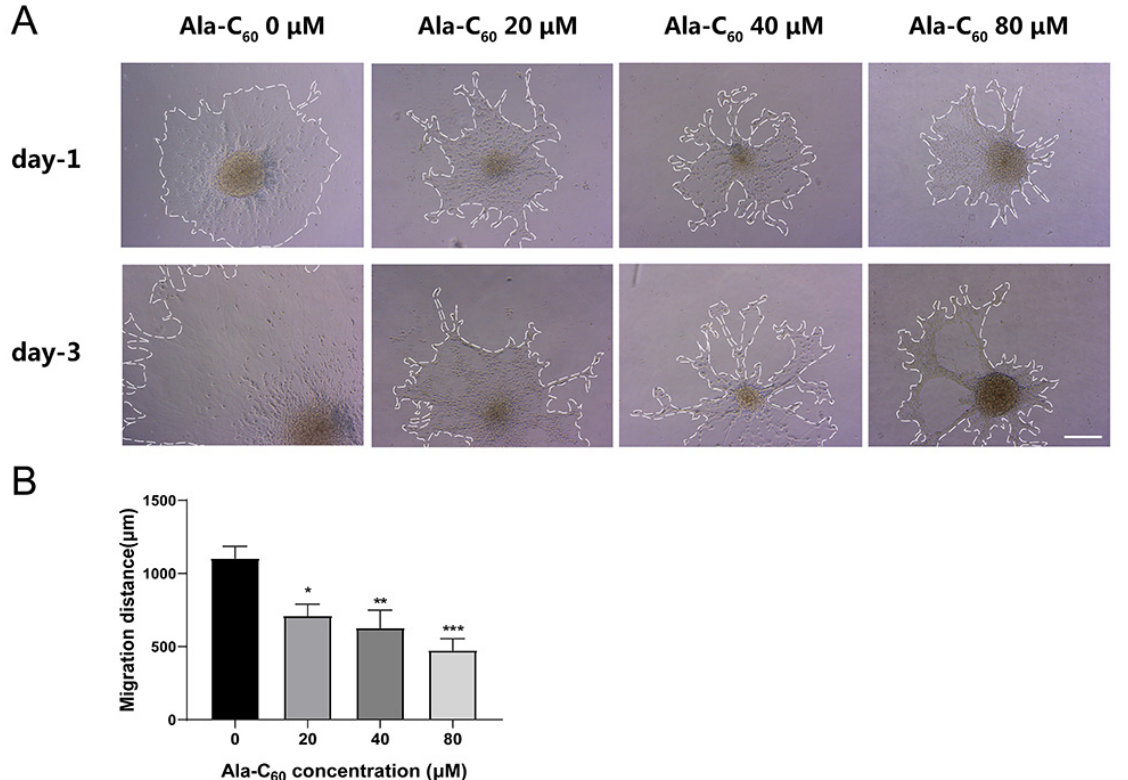
Figure 5. Ala-C 60 inhibited the migration of cultured neuroblasts. ( A ) Optical microscopy images of the migration distances of neuroblasts on the first and third day. Scale bar =200 µm. ( B ) Quantitative analysis of migration distance. * p < 0.05, ** p < 0.01, *** p < 0.001, according to ANOVA followed by LSD post hoc analysis.